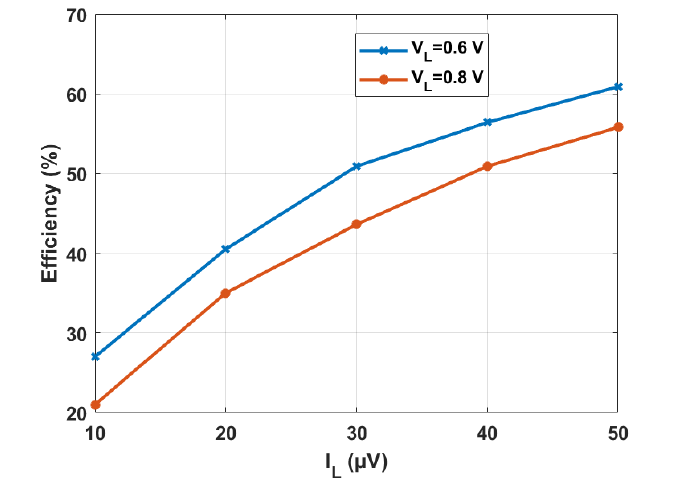
Figure 10. Power efficiency versus I L of SI boost regulator at V TEG = 50